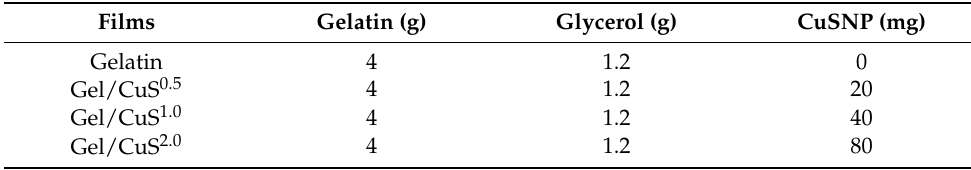
Table 1. Composition of gelatin/CuSNP nanocomposite